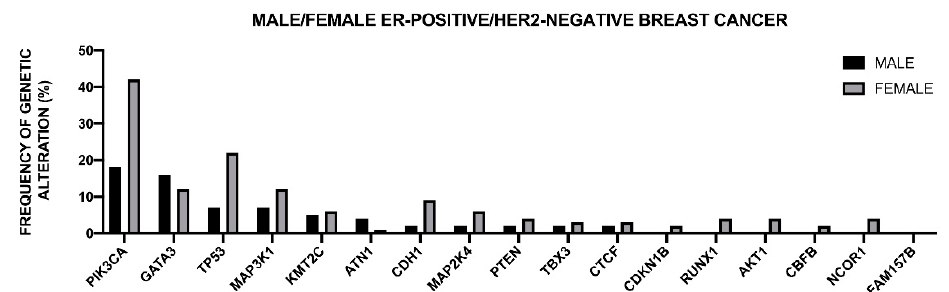
Figure 5. Comparison of the most recurrent somatic mutations reported in male ER + / HER2 - breast cancers, compared to female ER + / HER2 - breast cancers. The data shown in this figure are reported by Piscuoglio et al. 2016 [257].